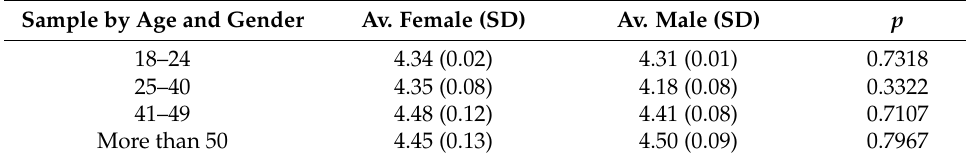
Table 3. T-test two-tailed (p) results of Q1–Q7 comparison, by age and gender.